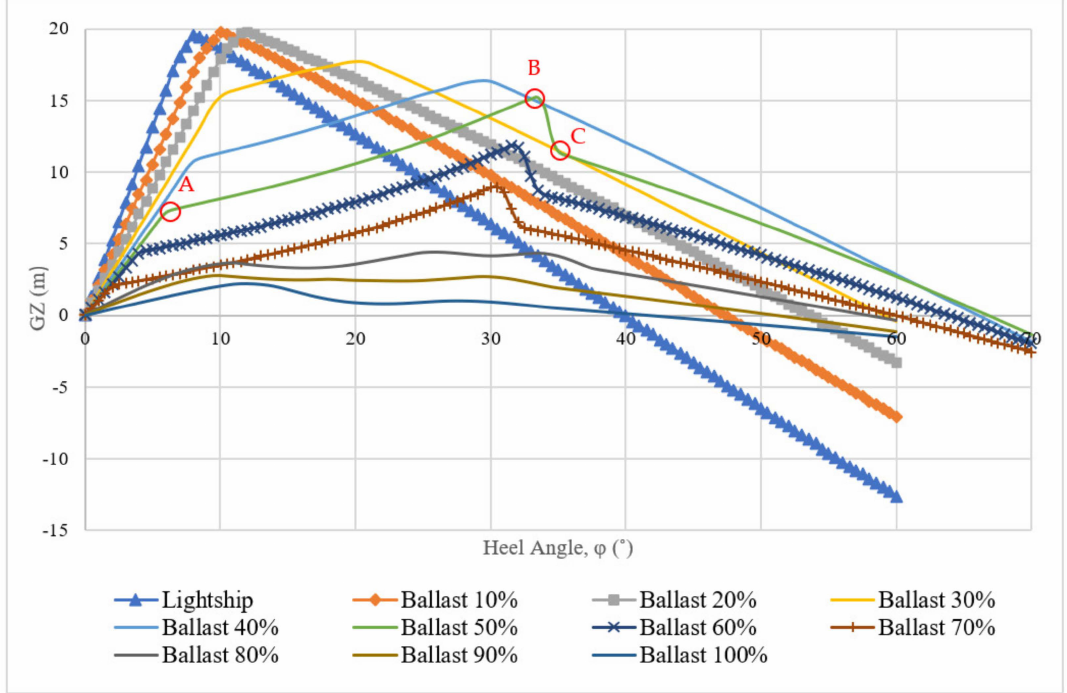
Figure 7. GZ curves for heeling where A refers to the submersion of the columns and B, C represent the submersion of the deck of the structure.